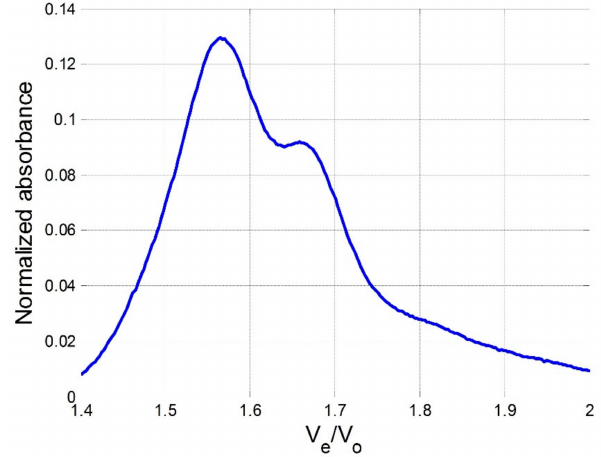
Figure 2. Size-exclusion chromatogram of c-kit21T12T21. The assignation of bands has been done according to the ratio elution volume / void volume, calculated according to reference